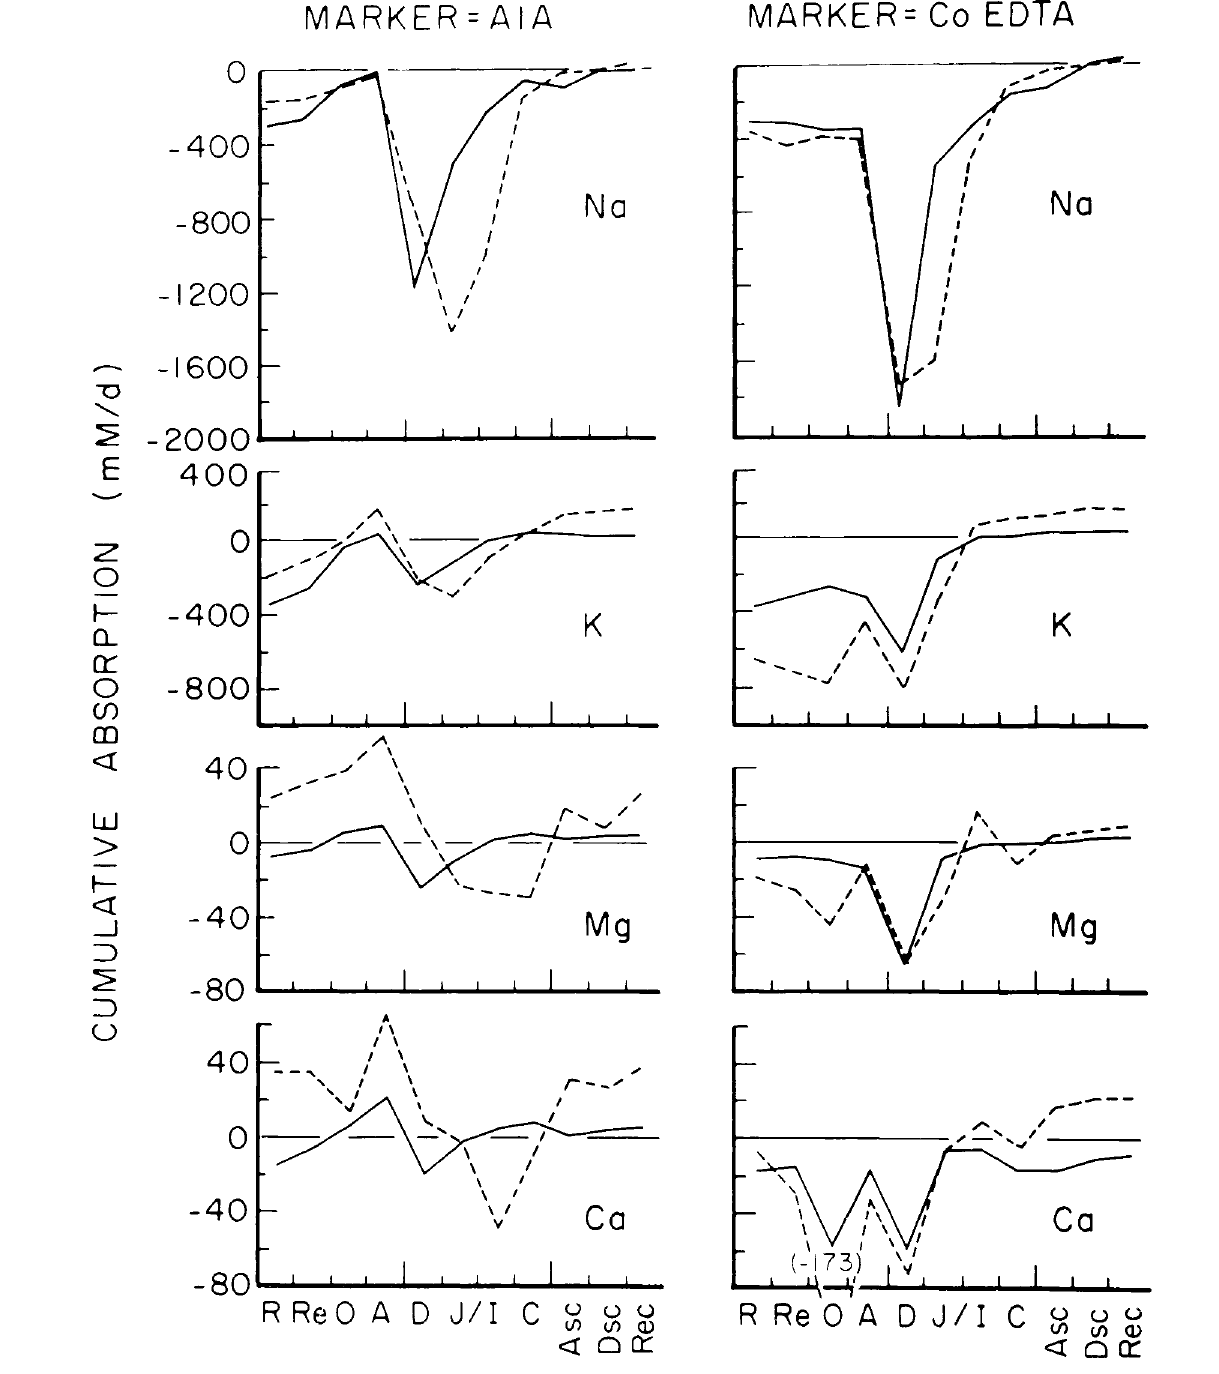
Fig. 2. Cumulative absorption of minerals in the alimentary tract of reindeer fed two different diets; Lichens; RF-71. Acid insoluble ash (AIA) left, and Co-EDTA right, were used as reference markers. For reasons described in the text, calculations of minerai exchange within the omasum are assumed to be less reliable than those for the rest of the alimentary tract. Negative changes indicate secretion and positive changes indicate absorption. Calculations lor each cation are made in relation to the respective dietary intakes. Abréviations are çiven in Fit:. !. Ratftgifer, Special Fsue No